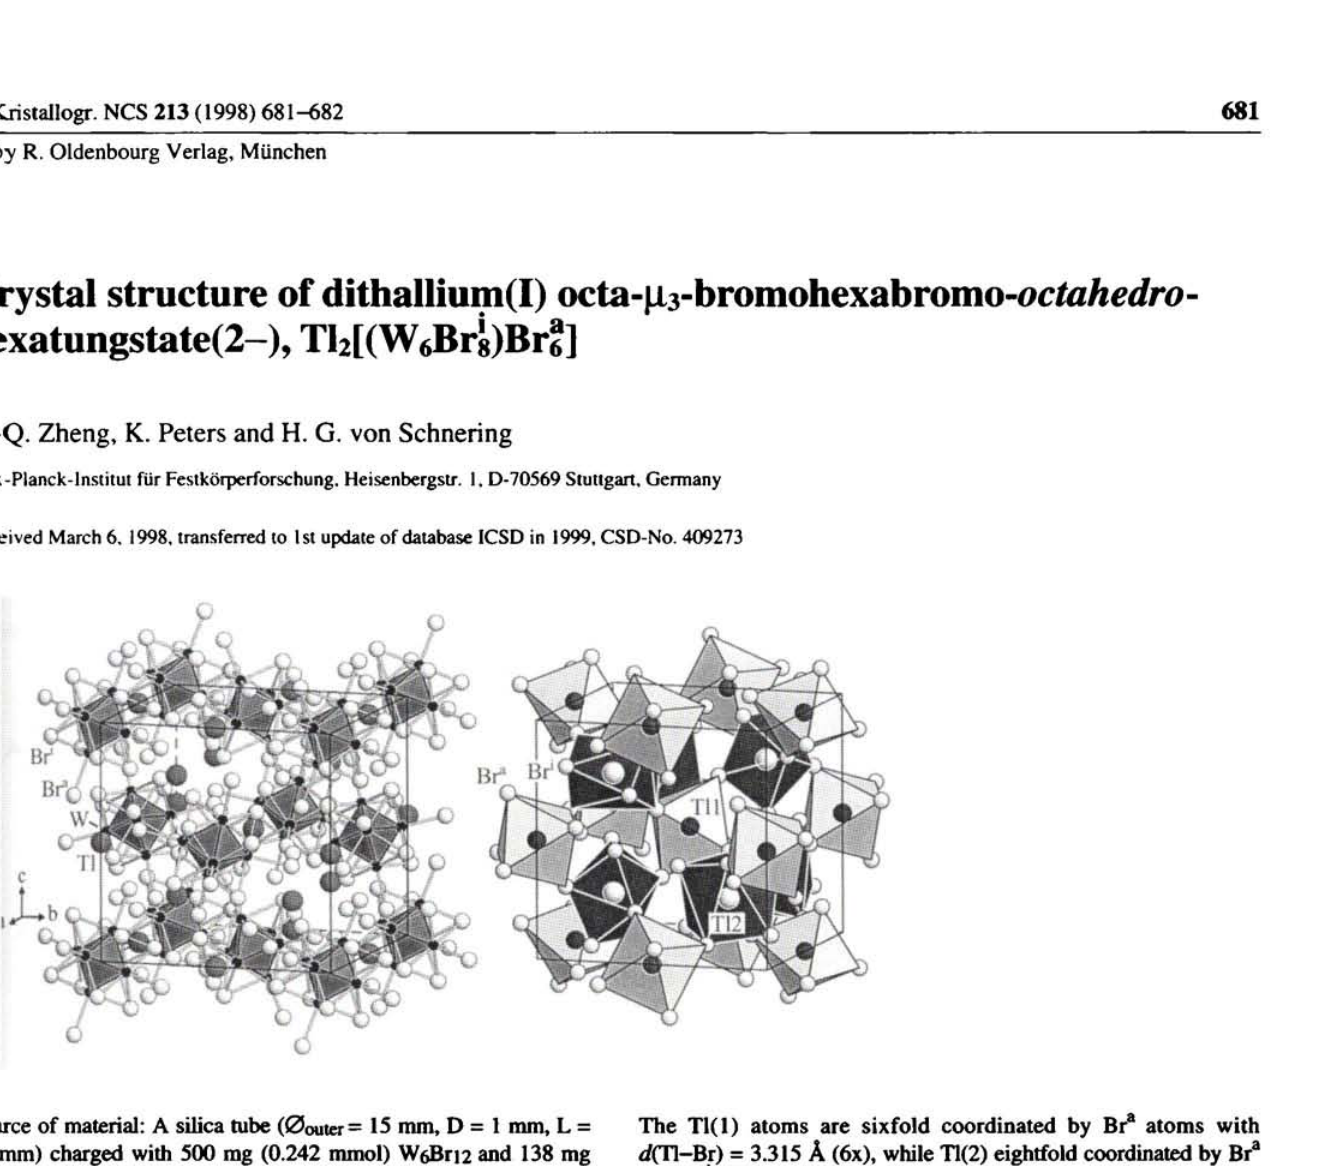
Table 1. Parameters used for the X-ray data collection Crystal: